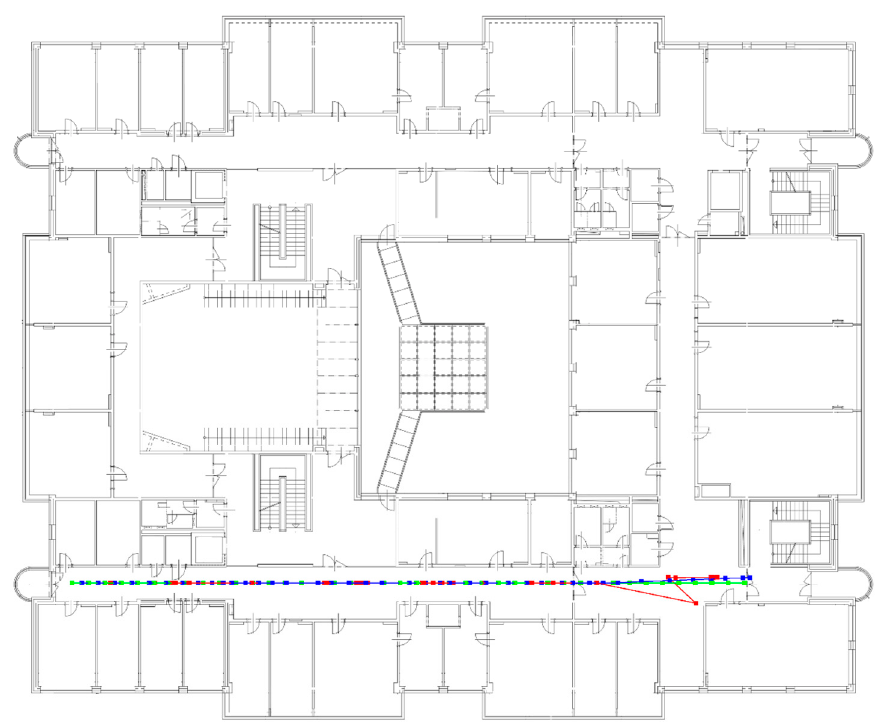
Mathematics 2020 , 8 , x FOR PEER REVIEW Figure 7. Visualization of test results for the Algorithm 4–path 1. Figure 7. Visualization of test results for the Algorithm 4–path 1.